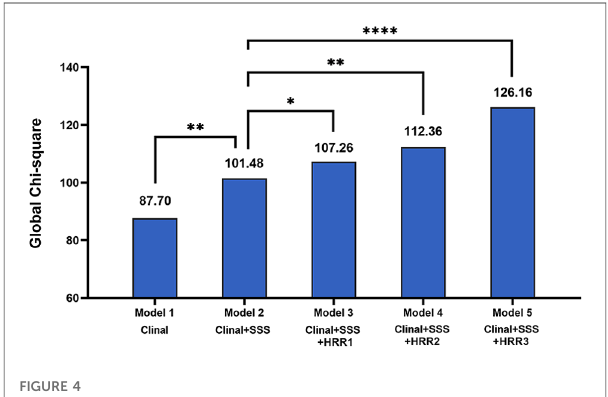
FIGURE 4 Incremental value of HRR variables for prediction of MACE beyond clinal data and SSS. MACE, major adverse cardiac events; HRR, heart rate recovery; SSS, summed stress score. * p <0.05, ** p <0.01, **** p <